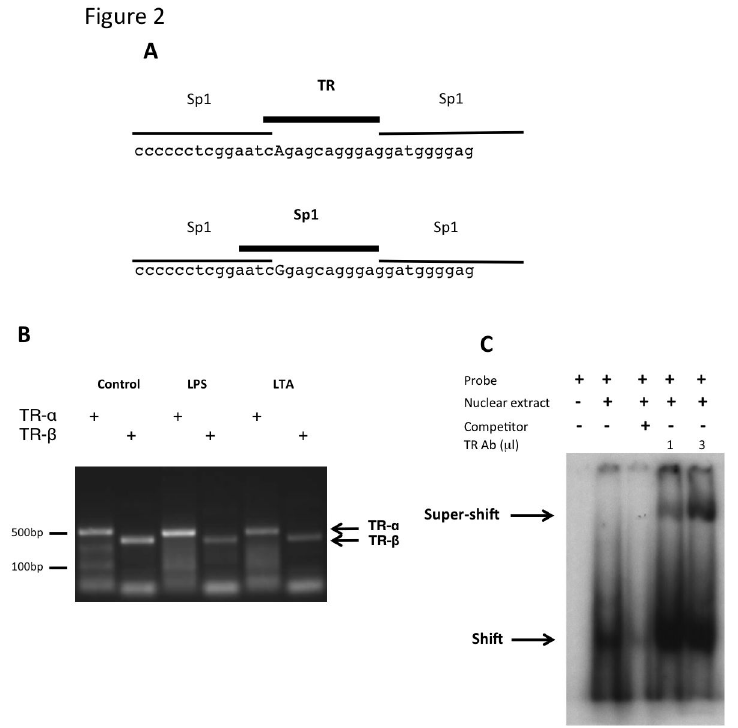
Figure 2. Bioinformatic analysis predicts a putative binding site for thyroid hormone receptors for the ‘A’ variant at